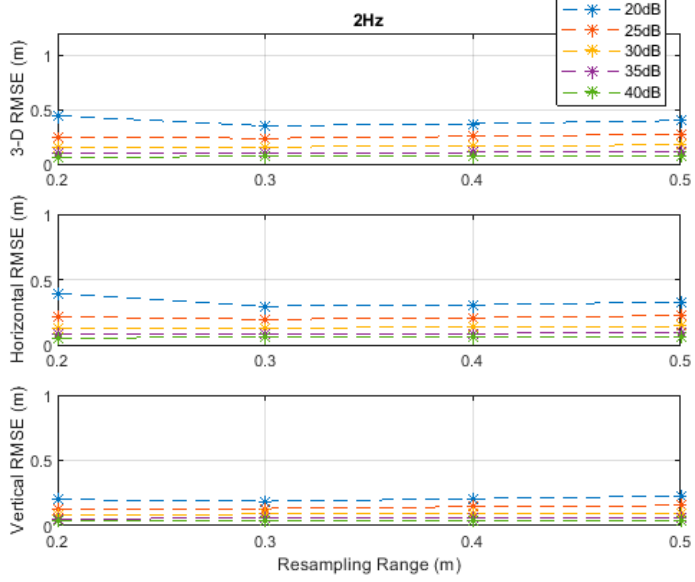
Figure 9. RMSE results along the horizontal circular path at a measurement update rate of 1 Hz.